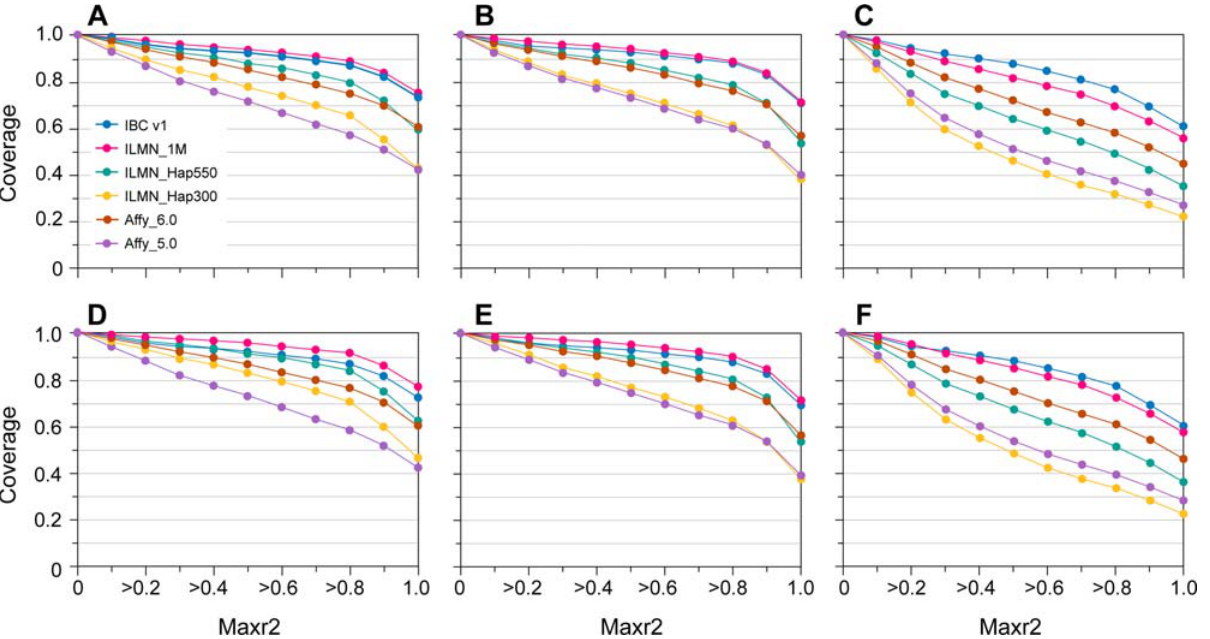
Figure 4. Coverage of IBCv1 versus GWAS products for Group1 loci in HapMap populations. Cumulative coverage (y axis) of the HapMap 22 release was assessed using Max r 2 ( 6 axis), at an MAF cutoff of 0.02, in CEPH (CEU) ( A ), Chinese (CHB) plus Japanese (JPT), ( B ) and Yoruba (YRI) HapMap individuals ( C ). Coverage was also assessed at an MAF cutoff of 0.05 in CEU ( D ), CHB + JPT ( E ), and YRI individuals ( F ). IBCv1 refers here to version1 ITMAT-Broad-CARe array using 45,237 SNPs passed by the manufacture. ILMN_1M, ILMNHap550 and ILMNHap300 refer to Illumina’s Human1M, HumanHap550 (555,352 SNPs) and HumanHap300 (317,503 SNPs) products, respectively. Affy_6.0 and Affy_5.0 refers to Affymetrix 6.0 & Affymetrix 5.0 array products containing , 906,600 SNPs & 500,568 SNPs